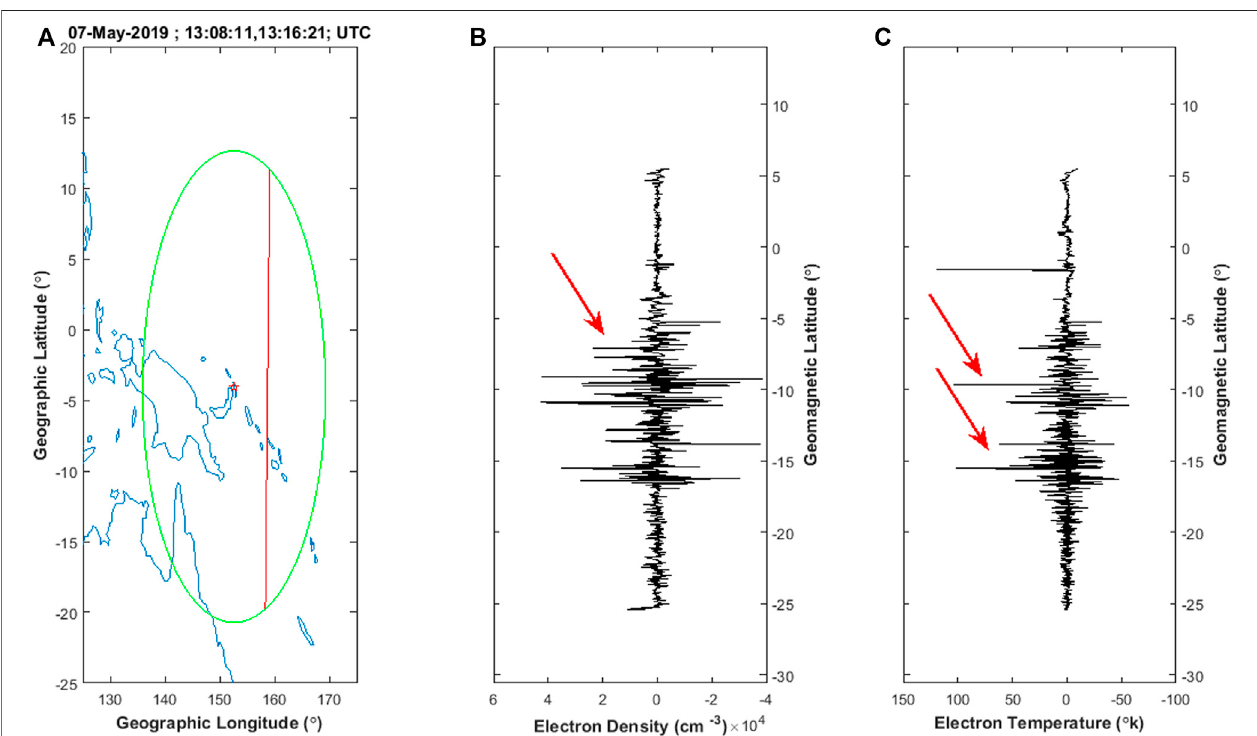
FIGURE 9 | Results of Swarm B track analysis for the New Guinea earthquake (May 7 , 2019), 7 days before earthquake day. (A) A map of the region with the longitude in the horizontal axis and latitude in vertical one is represented. A red asterisk, a brown line, and a yellow circle represent the earthquake epicenter, the track, andDobrovolsky ’ sarea,respectively.ThetrackcrossedtheDobrovolsky ’ sareabetweenthe13:08:11and13:16:21UTC. (B,C) showthedifferencesbetweenthetime series of the measured electron density and temperature and a polynomial of degree 20 fi tted along the same track. The vertical axis represents the geomagnetic latitude.